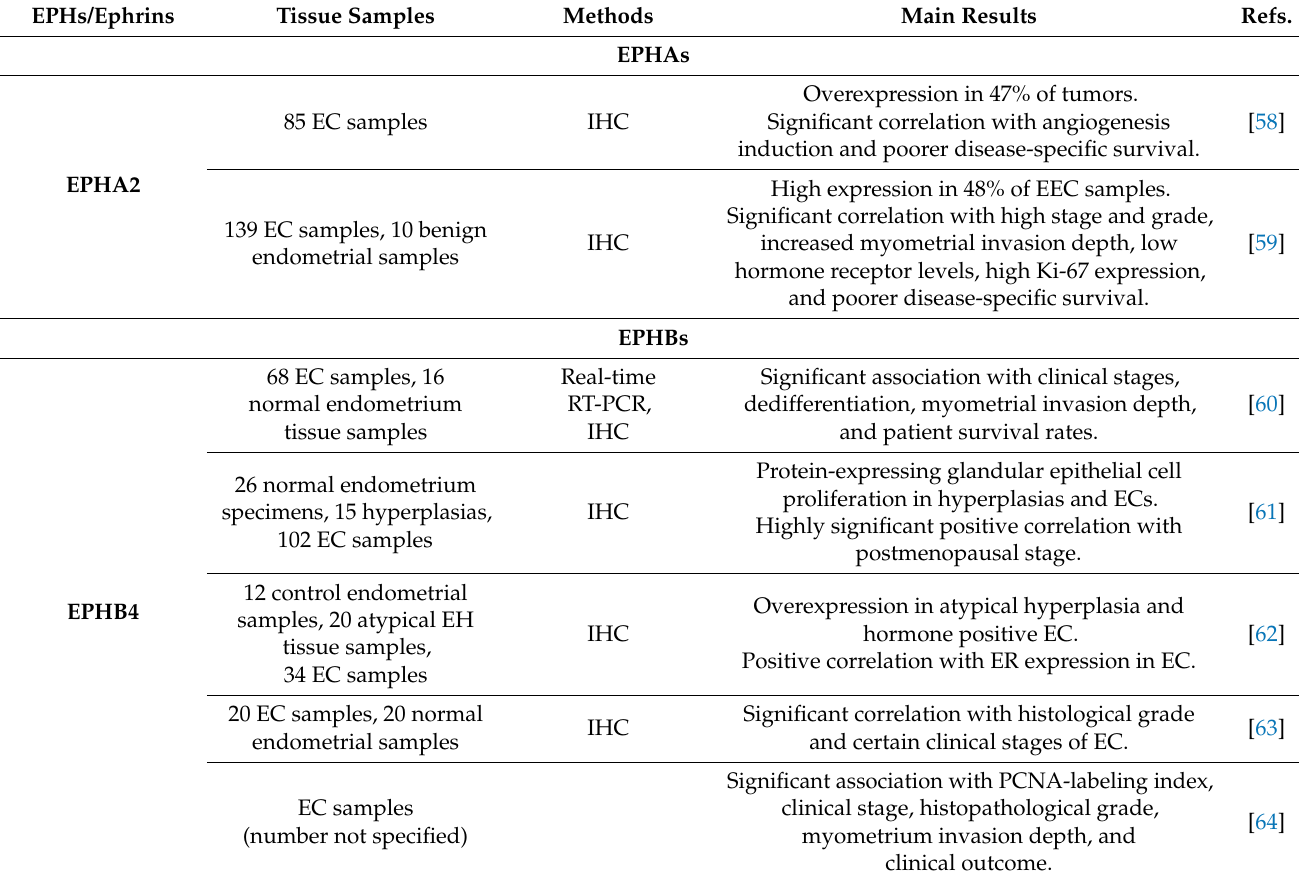
Table 5. The role of the EPH/ephrin system in EC tissue